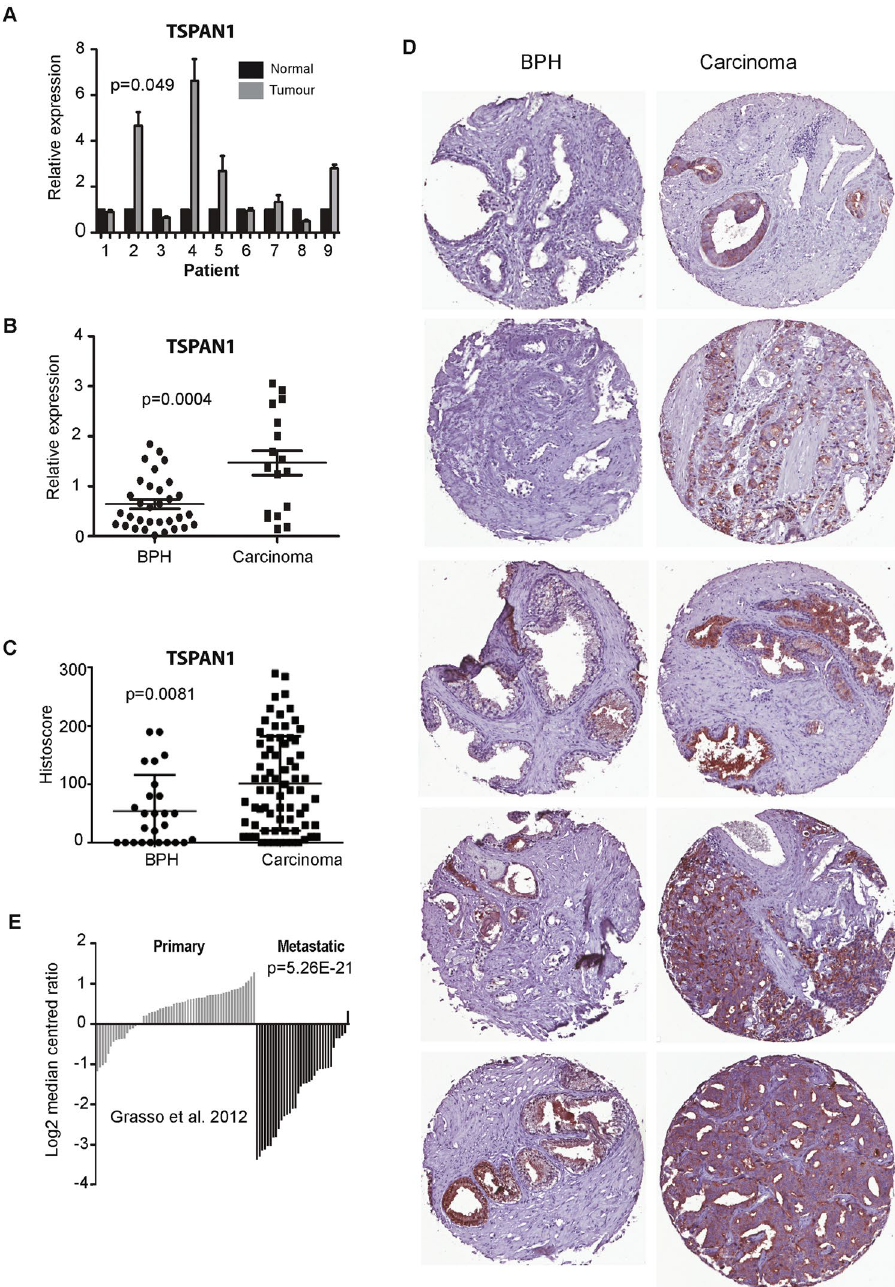
Figure 2. TSPAN1 is upregulated in prostate cancer tissue. ( A ) Real-time PCR analysis of TSPAN1 mRNA from normal and matched prostate cancer tissue from 9 patients obtained from radical prostatectomy. (B) We also analysed 32 benign samples from patients with benign prostate hyperplasia (BPH) and 17 malignant samples from transurothelial resection of the prostate (TURP) samples. (C) Analysis of TSPAN1 protein levels in patients with BPH or prostate cancer by Tissue Microarray (TMA). (D) Representative cores from each TMA. (E) TSPAN1 gene expression levels in prostate tissue from the primary or metastatic site in data published by Grasso et al . 33